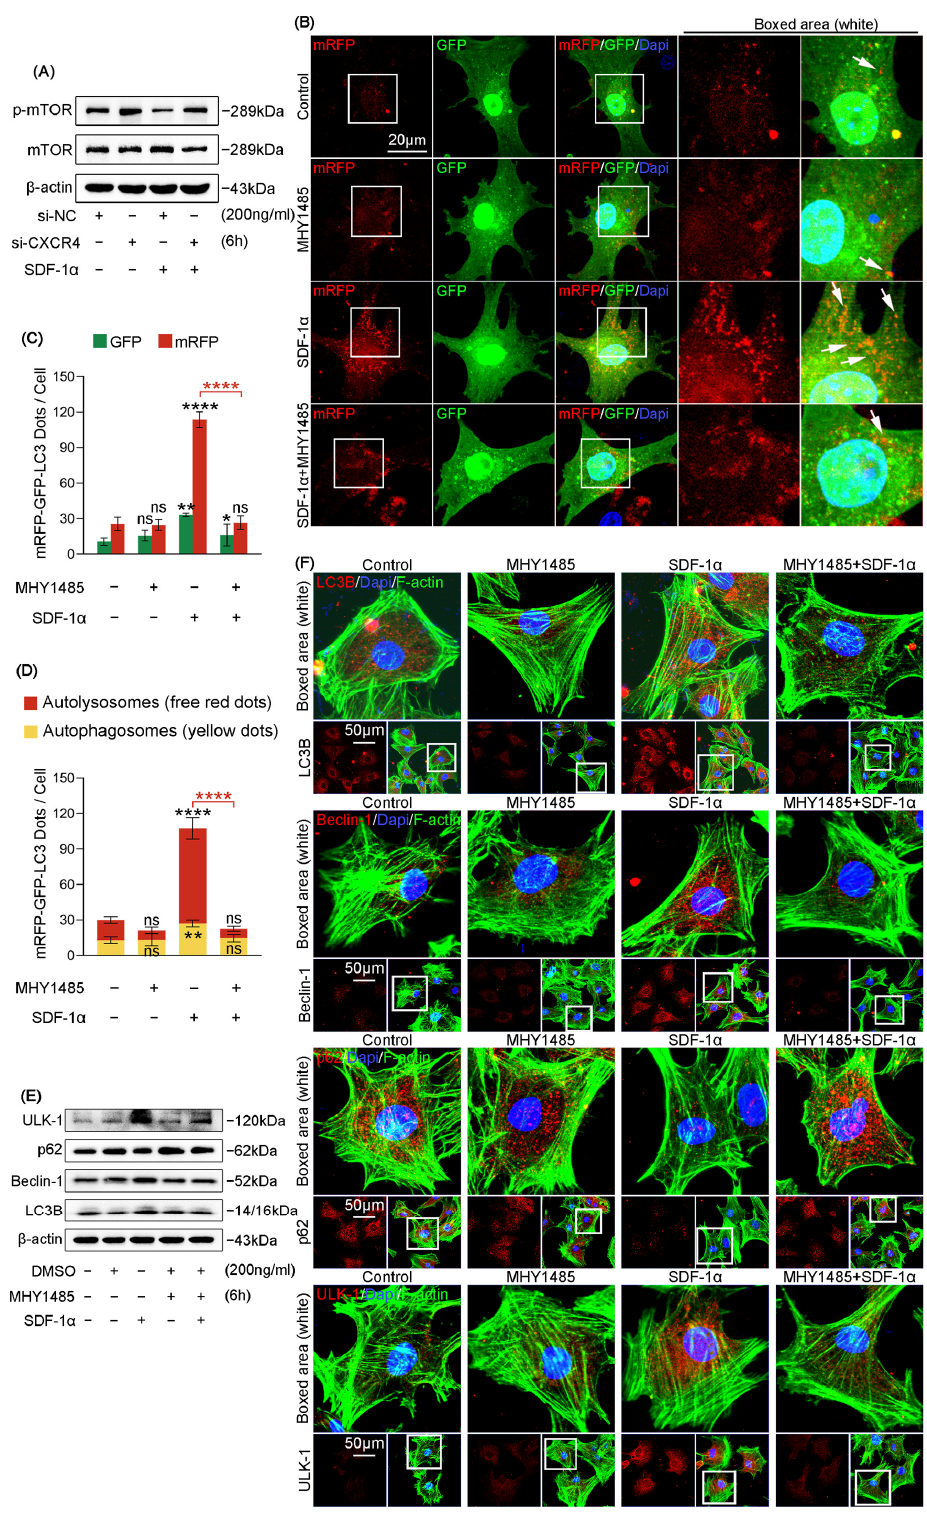
Figure 5. SDF-1 α enhances autophagy through inhibition of mTOR/p-mTOR signaling in chondro- cytes ( A ) Representative western blots showing the expression of mTOR and p-mTOR in chondrocyte treated with SDF-1 α (200 ng/mL) for 6 h in the presence or absence of CXCR4 siRNA (50 nM). ( B ) mRFP-GFP-LC3 adenovirus double label assay indicating that MHY1485 (100 nM) impaired the increase of autophagy flux in chondrocytes induced by SDF-1 α (200 ng/mL) for 48 h. Free red dots represent autolysosomes. Yellow dots represent autophagosomes. White arrows point to the autoly- sosome. We counted three cells from three independent experiments in each group to detect the